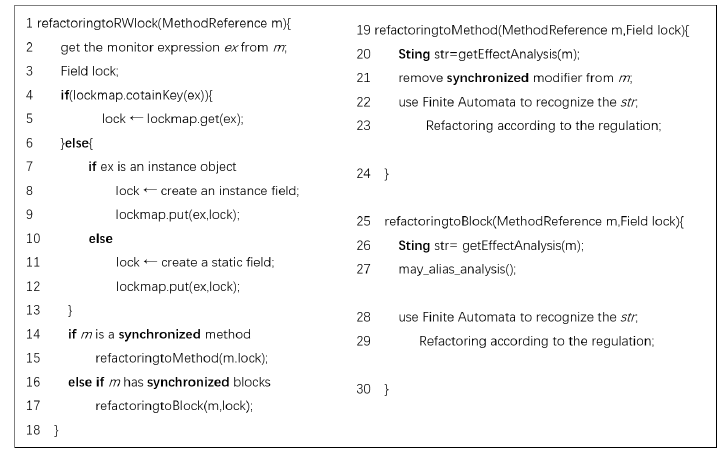
Figure 7. Refactoring algorithm for fine-grained ReentrantReadWriteLocks